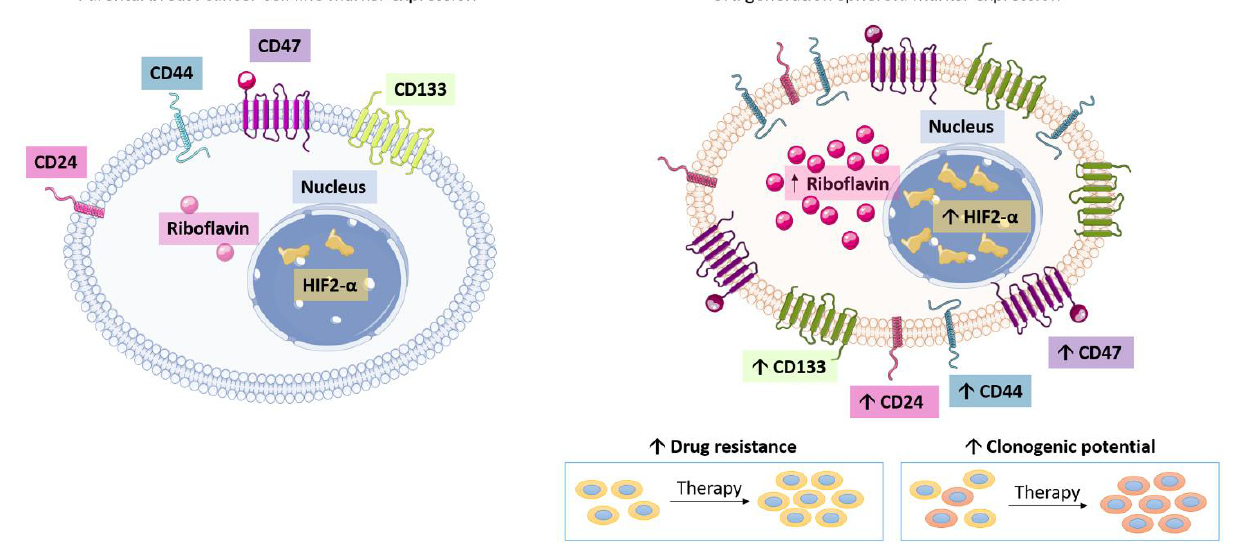
Figure 13. Characterization and comparison of 2D monolayer breast cancer cells and 3rd generation spheroids. 3rd generation breast cancer spheroids express increased CSC markers CD133, CD24, CD44, and CD47 expression; elevated riboflavin accumulation; and increased HIF-2α, compared to the monolayer counterparts. Abbreviations: CSC, cancer stem cell.